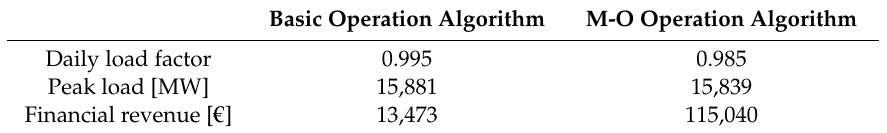
Table 3. Comparison between the multi-objective optimization and the basic operation